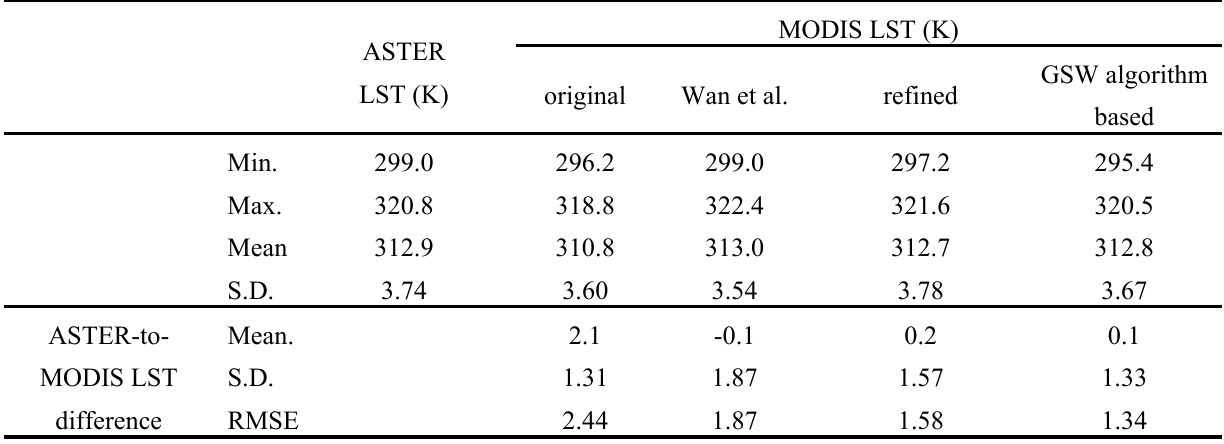
Table 2. Comparison of the MODIS LST (original and corrected by three approaches) with reference to the ASTER LST, all corrected for terrain